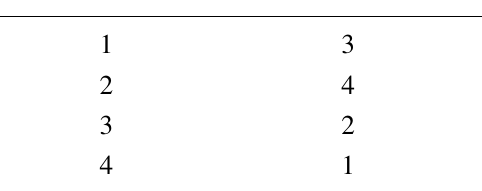
Table 1. Details of the connection